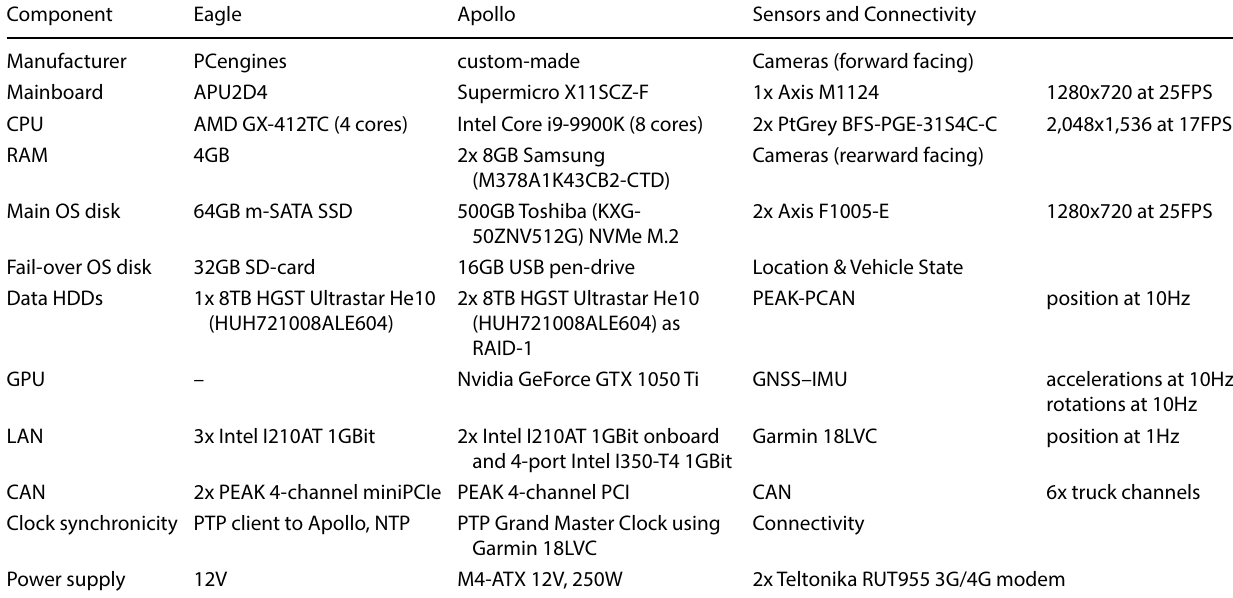
Table 1 System components for the data logging system